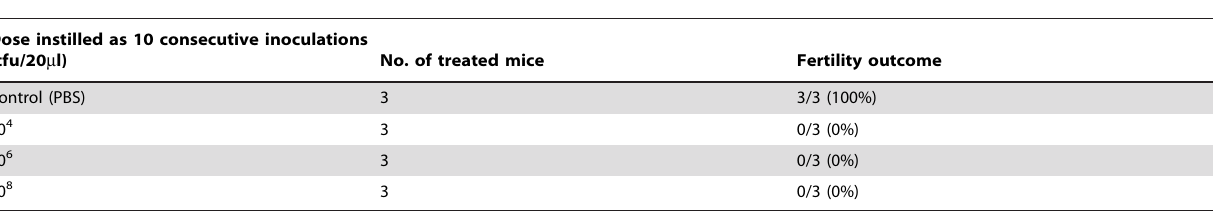
Table 1. Effect of repeated intravaginal inoculations of spermagglutinating strain of S. aureus on fertility outcome in mice.